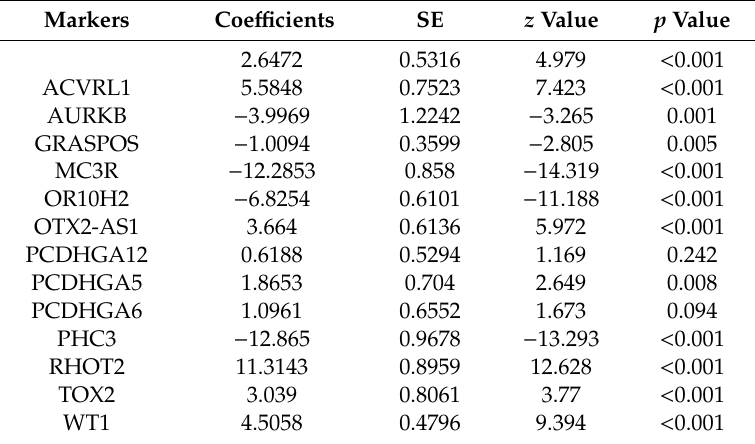
Table 2. Characteristics of 13 promoter markers in the Training data